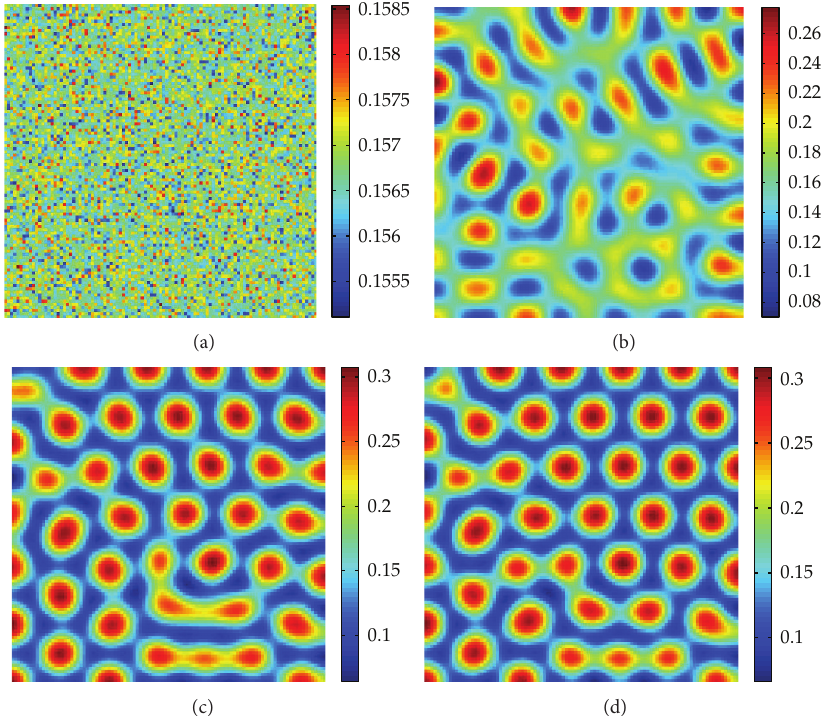
Figure 4: Spots pattern formation for model (5) by taking (𝑏,𝑠) = (0.8, 10) . Iterations: (a) 0 ; (b) 2 × 10 5 ; (c) 5 × 10 5 ; (d) 1 × 10 6 .